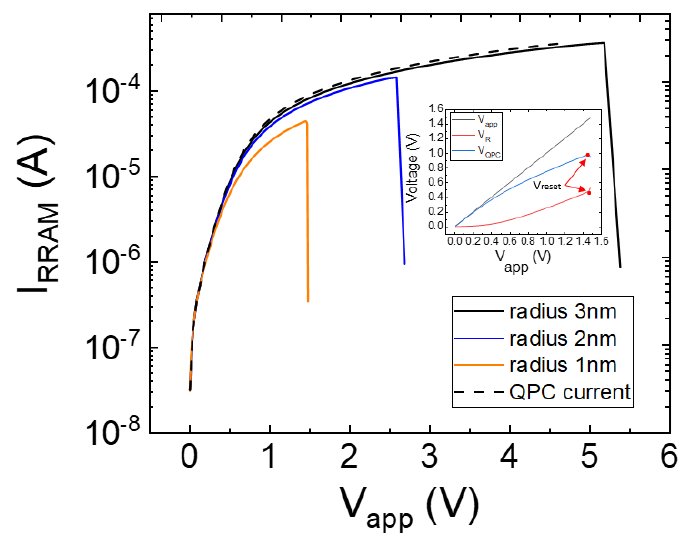
Figure 2. Simulated current versus voltage and description of the different components; see the voltage components in the inset (V QPC + V R = V app ). Three CF radii are considered (1 nm, 2 nm, 3 nm) for cycles #1, #2, and #3 (inset: voltage curves for cycle #1). The QPC parameters are: α = 15 eV − 1 , β = 0.55, Φ = 0.26 eV, N = 2.